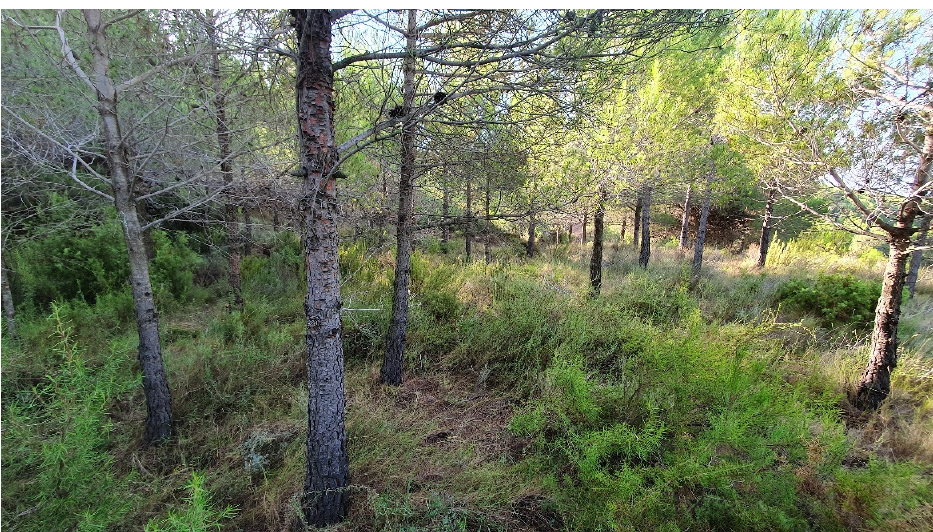
Figure 1. View of the sample stand (August 2021).